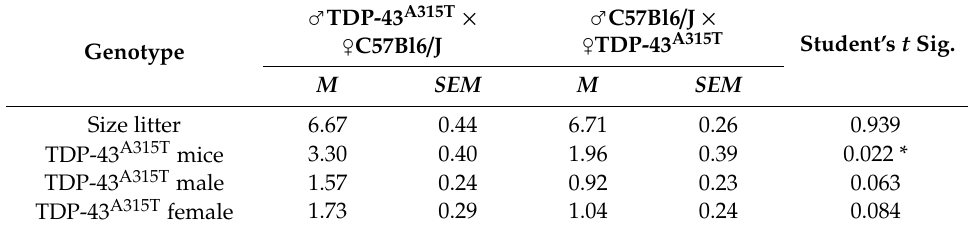
Table 1. Analysis of Prp TDP-43 A315T transmission across F1–F4